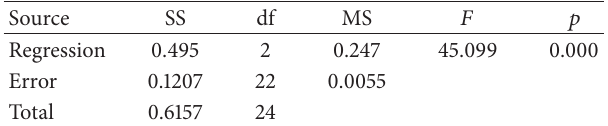
Table 3: Multiple regression results.